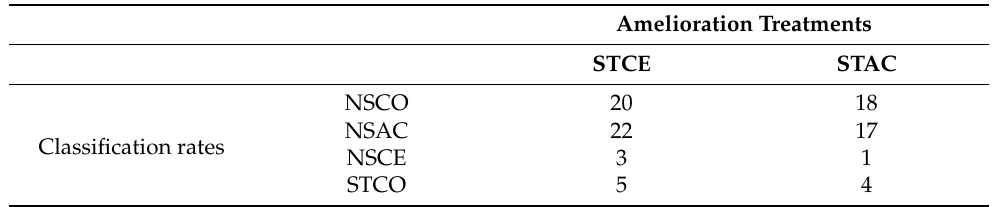
Table 5. Classification rates for the STCE and STAC treatments according to the machine learning model developed, with an overall success of